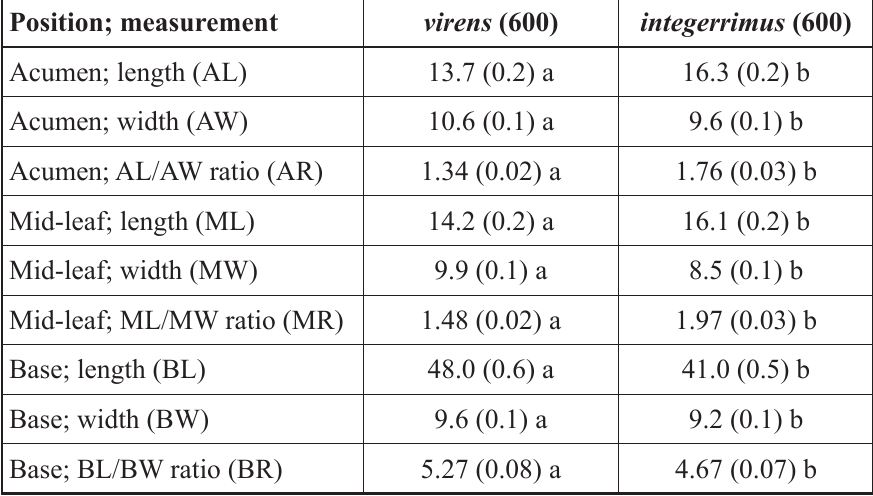
Table 3. Means plus standard errors for cell measurements in the acumen (20 cells per leaf), in mid-leaf (20), and in the sheathing base (20) from three leaves in each of ten specimens of Oncophorus virens and O. integerrimus Hedenäs sp. nov. The number of measured cells at each position, n, is indicated after the species. Significant differences between species revealed by the Mann-Whitney U-test are indicated by different letters appended after the values in the respective columns, for the Bonferroni corrected p values corresponding with p <